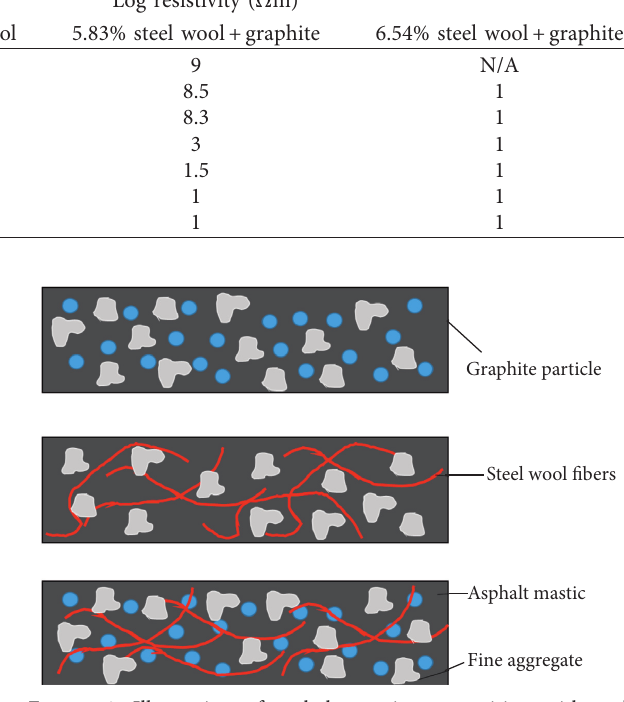
Table 1: Conductive particles-bitumen ratio for asphalt mortar systems at different conductive additive content [25]. Conductive additives content (vol %)